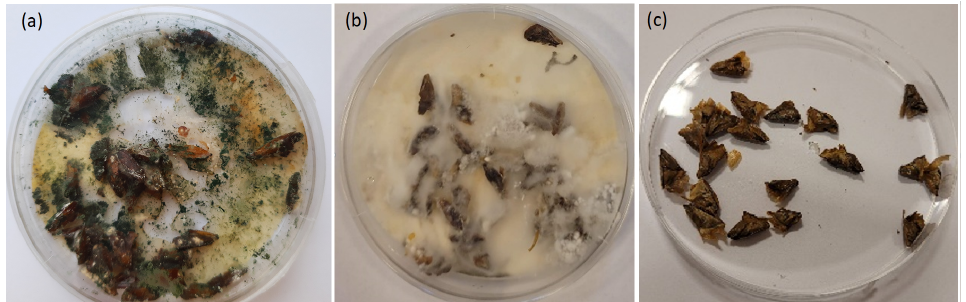
Figure 5. Example of a Petri dish with fir seeds and mycelium covering the surface. ( a ) green, ( b ) white, and ( c ) uninfected/control samples. (photo M. Fasano, R.